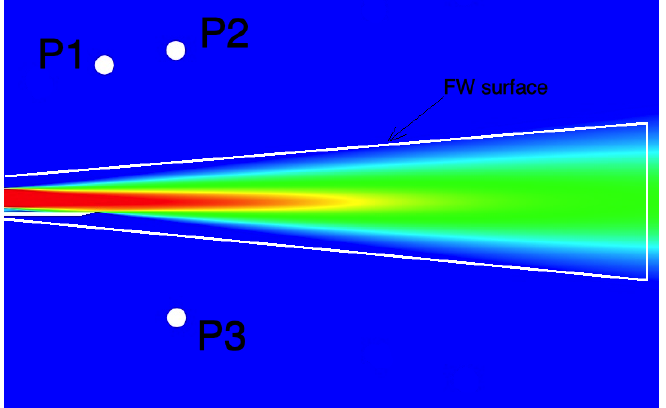
Figure 9. Locations of the three Probes, and the Ffowcs-Williams integration surface.